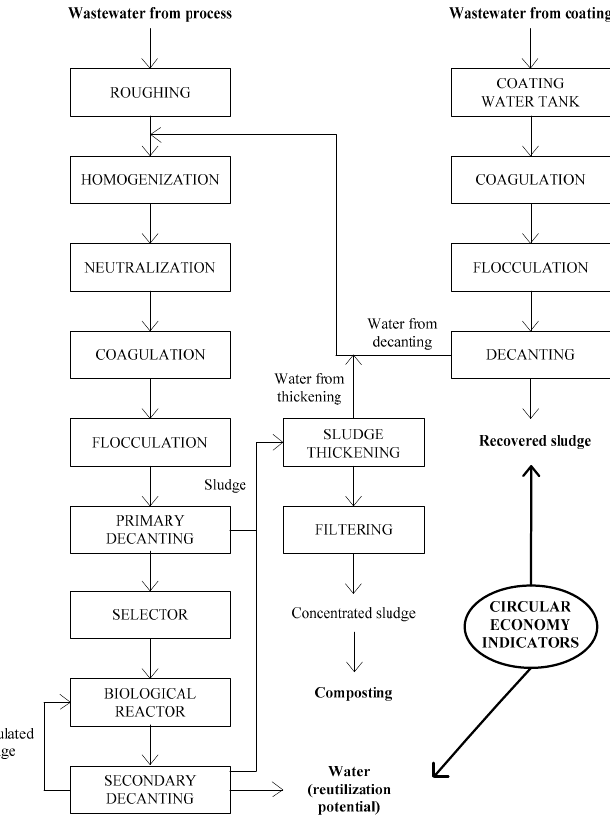
Figure 1. Flowchart of the paper mill wastewater treatment plant.